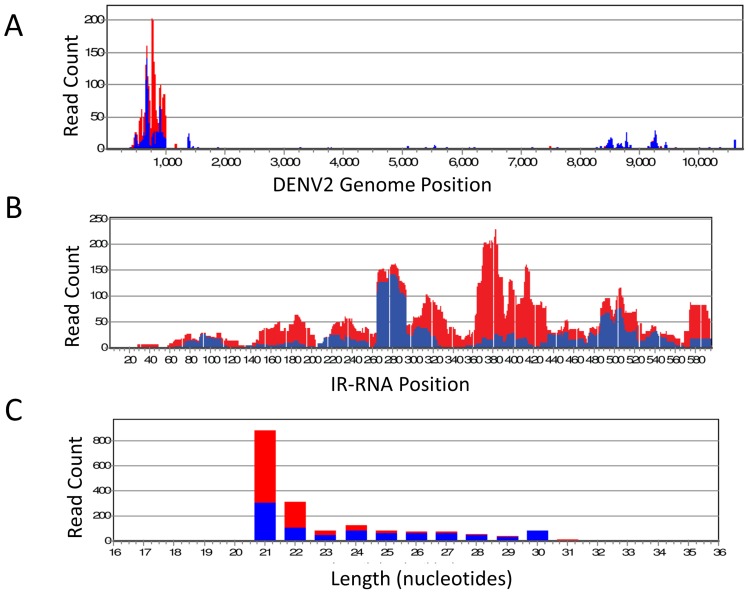
NextGen small RNA sequencing to reveal processing of the IR-RNA into siRNAs in Carb109M mosquitoes.(A) Alignment of small RNA sequences derived from the IR-RNA to the DENV2-Jamaica1409 genome (10,723 nucleotides). (B) Alignment of small RNA sequences to the 568 nt region of DENV2-Jamaica1409 RNA targeted by the IR (Mnp) effector gene. (C) Size distribution of small RNA reads. Y-axis: Read Count  =  number of small RNAs detected by NextGen sequencing. X-axis: Distribution of small RNA sequences mapped to the DENV2-Jamaica1409 genome. Red bars, negative-sense small RNAs; blue bars, positive-sense small RNAs.